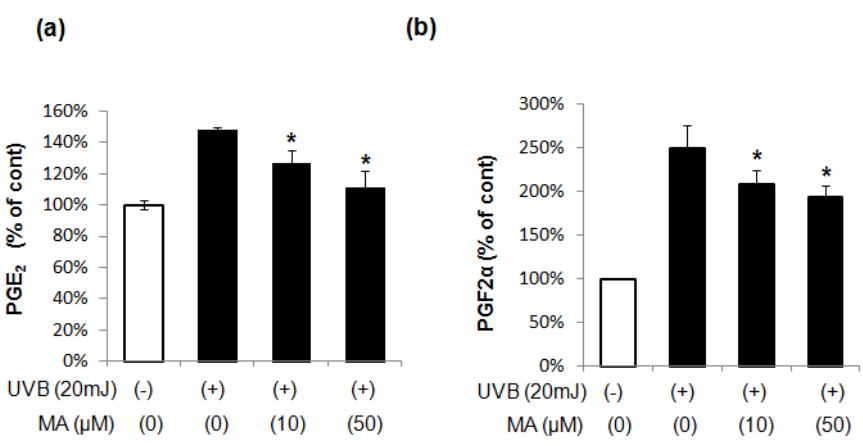
Figure 2. The levels of lipid mediators of inflammation ( a ) PGE shown are the mean ± S.D., n = 3. * p < 0.05 vs. UVB-irradiated control; MA: Madecassoside.